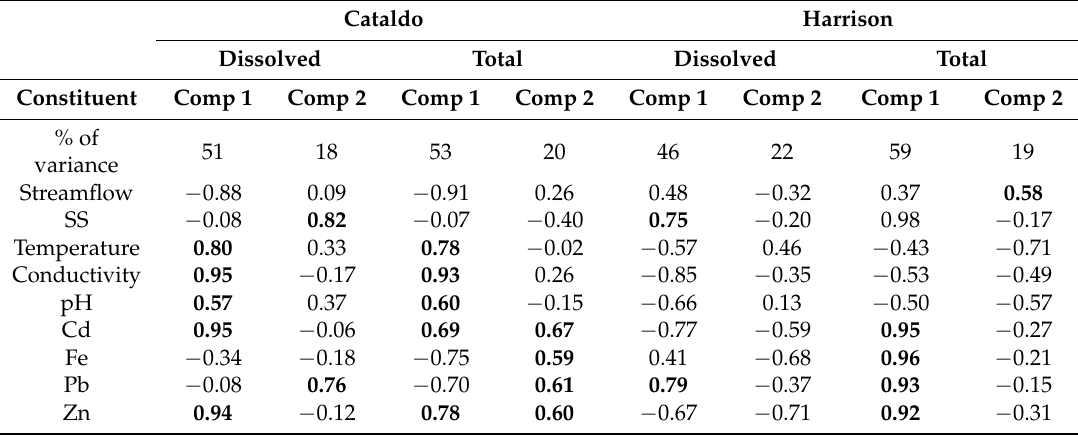
Table 3. Results of principal components analysis for dissolved and total metal concentrations and physicochemical parameters of streamflow, suspended sediment, water temperature, conductivity, and